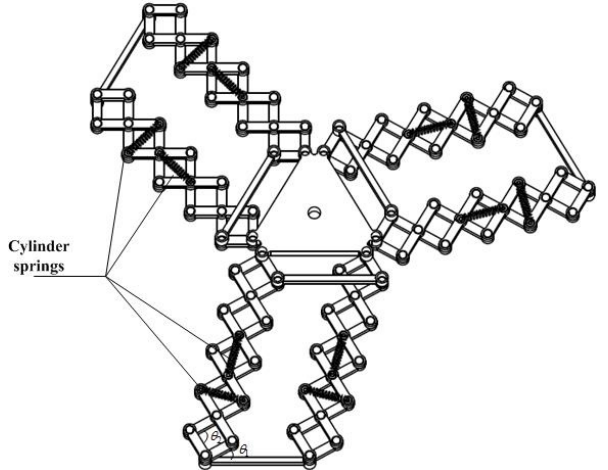
Figure 21. Stiffness contours of the platform in case 4.